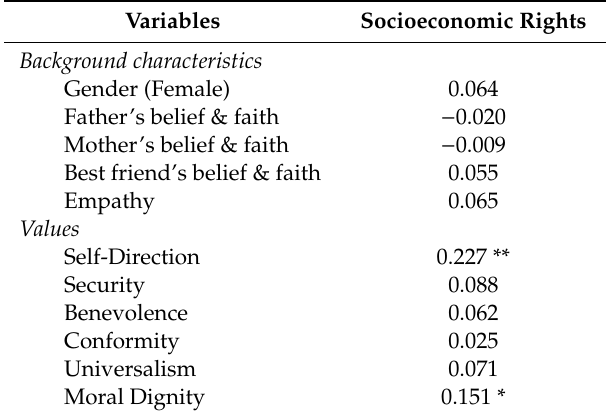
Table 14. Regression analysis for socioeconomic rights with weights ( β ) for each variable and total explained variance ( R 2 and adjusted R 2